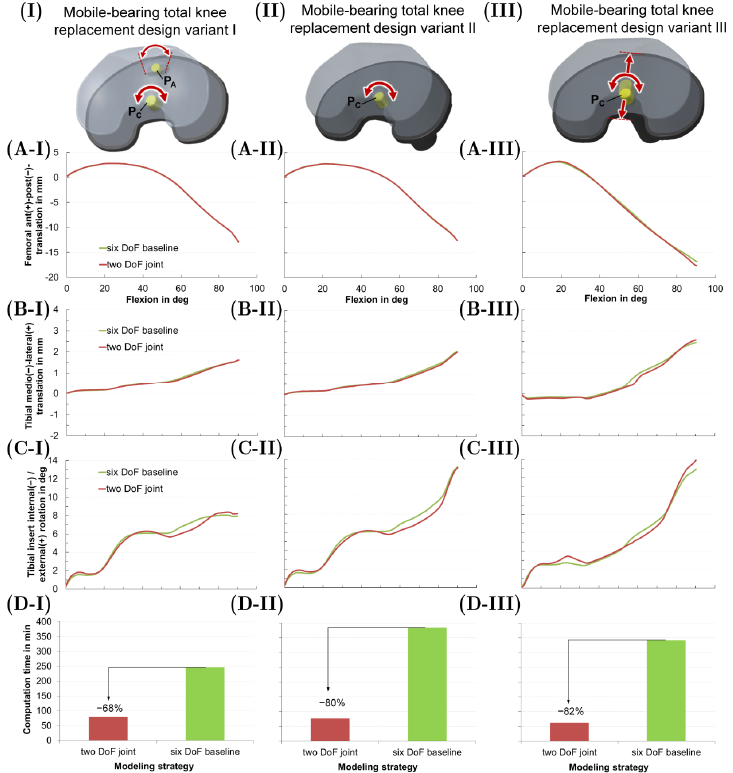
Figure 6. Tibiofemoral kinematics during the dynamic squat motion for the three mobile-bearing design variants I–III in case of two modeling strategies with different joint topologies (first: six DoF baseline; second: two DoF joint). Evaluation of the femoral anterior(+)-posterior( − ) translation ( AI – AIII ), tibial medio()-lateral(+) translation ( BI – BIII ), and tibial insert rotation with respect to the tibial tray ( CI – CIII ). Furthermore, the computation time of the modeling strategies 1 and 2 was compared for the different mobile-bearing design variants ( DI – DIII